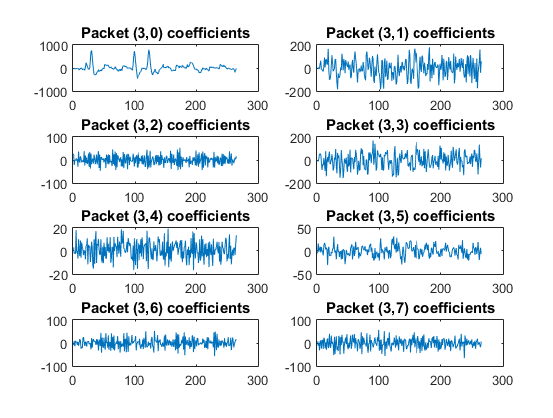
Fig. 8. 3rd level decomposition